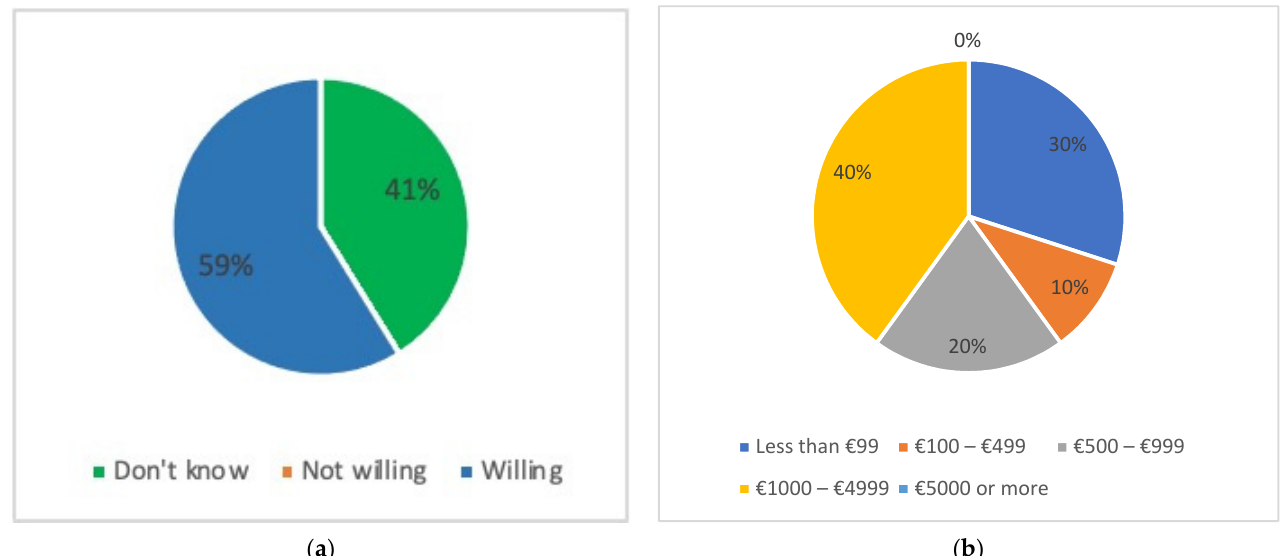
Figure 10. ( a ) Willingness to pay for SG technologies in La Graciosa; ( b ) Range of payment respondents are willing to make in La Graciosa.